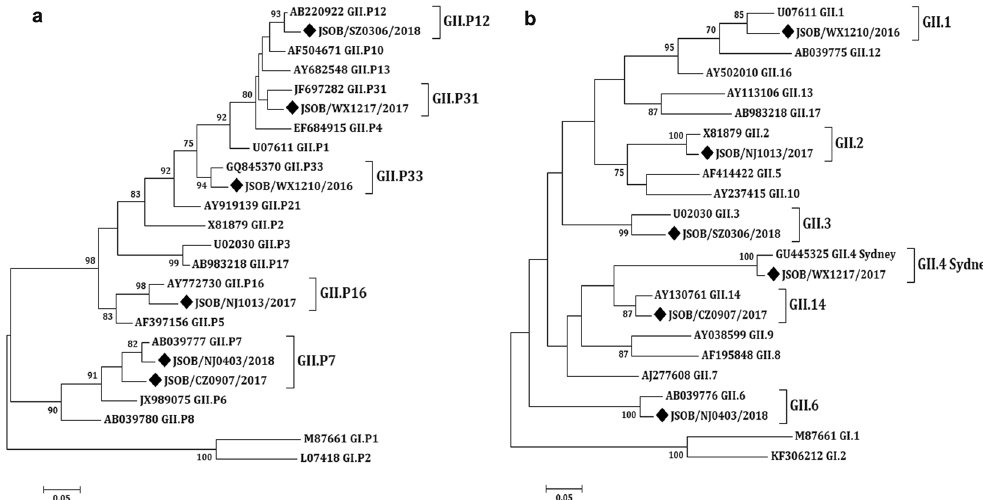
Figure 3. Phylogenetic analyses of the recombinant strain sequences based on partial RdRp and full-length capsid regions (VP1). ( a ) Phylogenetic tree of a 750 bp region of RdRp. ( b ) Phylogenetic tree of complete VP1. The trees were constructed using the Maximum Likelihood analysis and the evolutionary distances were computed using the Kimura 2-parameterþG method available in MEGA 7.0. Bootstrap values ( > 70%) are shown as percentages derived from 1,000 samplings at the nodes of the tree. The scale bars represent the number of nucleotide substitutions per site. The new norovirus strains reported in this study are indicated with solid black